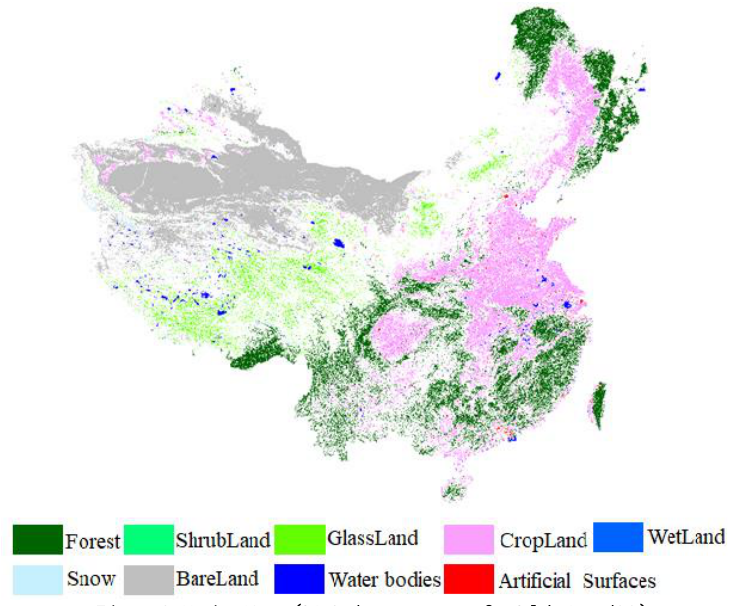
Figure 2. Union Map (GLC dataset except for